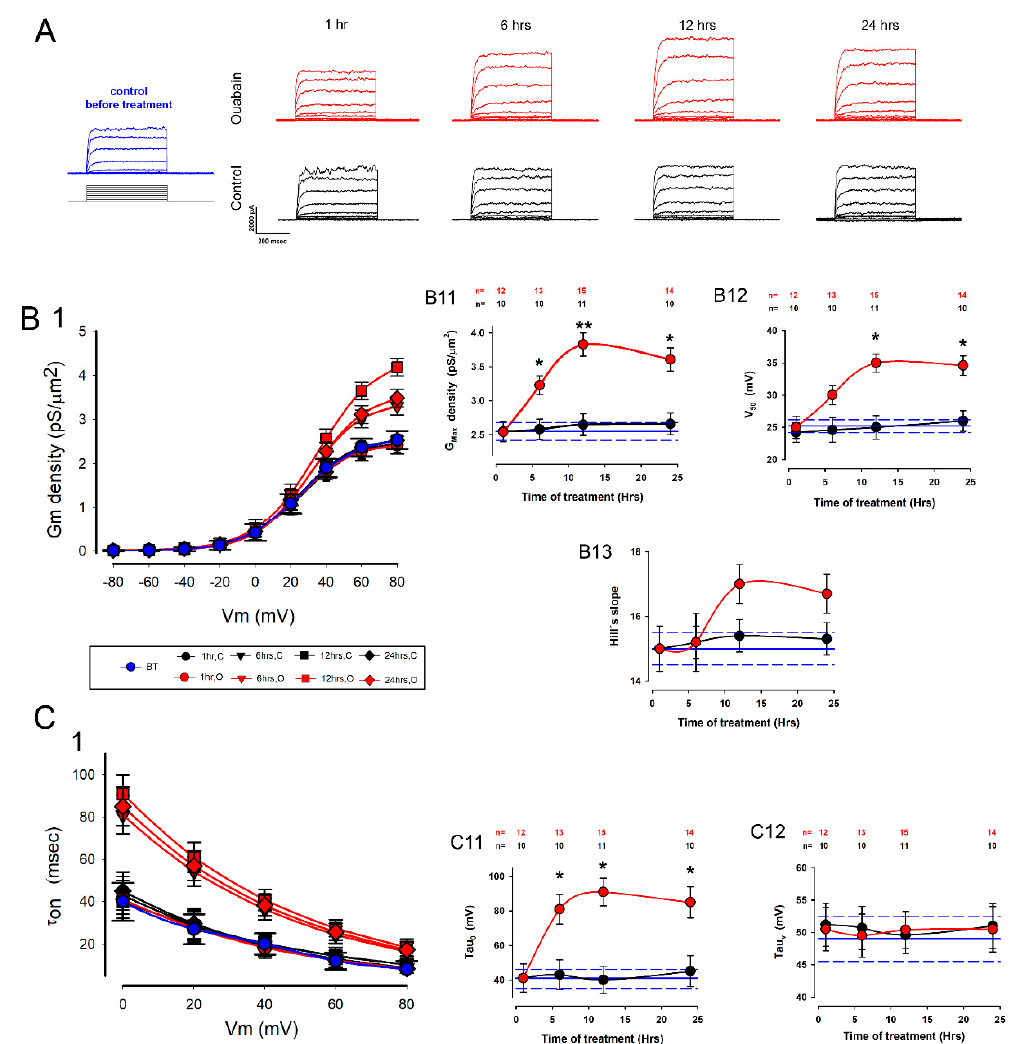
Figure 2. Effects of ouabain on the potassium currents of cells in mature monolayers (MM). ( A ) A representative series of currents recorded in response to the same voltage stimulation protocol, in cells under different treatment conditions. The series depicted in blue on the left side is representative of what was observed before treatment; the red colored series are representative of what was obtained at different treatment times with 10 nM of ouabain, while the black series are representative of the corresponding controls. ( B ) ( B1 ) shows the relationships between the Gm density and the voltages for the different treatment times with ouabain ( in red ) and the controls ( in black ). The relationship between the recordings before treatment (in blue) is included. In the graph, the different plots are superimposed, as indicated in the box at the bottom; the circle, downward triangle, square and rhombus correspond to the times of 1, 6, 12 and 24 hours after treatment with ouabain. ( B11 – B13 ) compare the parametric values of the G max density, V 50 and Hill’s slope of treated (red) and untreated (black) cells at the different times of treatment. ( C ) ( C1 ) shows the relationships between the activation time constant (tau on) and the voltage of the different treatment times with ouabain (in red), the controls (in black), and the relationship of the registers before treatment (in blue); in the graph, the different plots are superimposed, in the same way as in plot ( B1 ). ( C11 , C12 ) compare the parametric values of τ 0 and τ v of treated (red circles) and untreated (black circles) cells at different treatment times. In plots ( B11 – B13 , C11 , C12 ) the horizontal, blue lines indicate, as a reference, the mean (solid) and the error (dashed) of each parameter estimated from the cells before treatment. The asterisks denote a statistically significant difference between the means ( ± SE) of treated versus untreated cells; (*) indicates a p < 0.05 and (**) indicates p < 0.001.